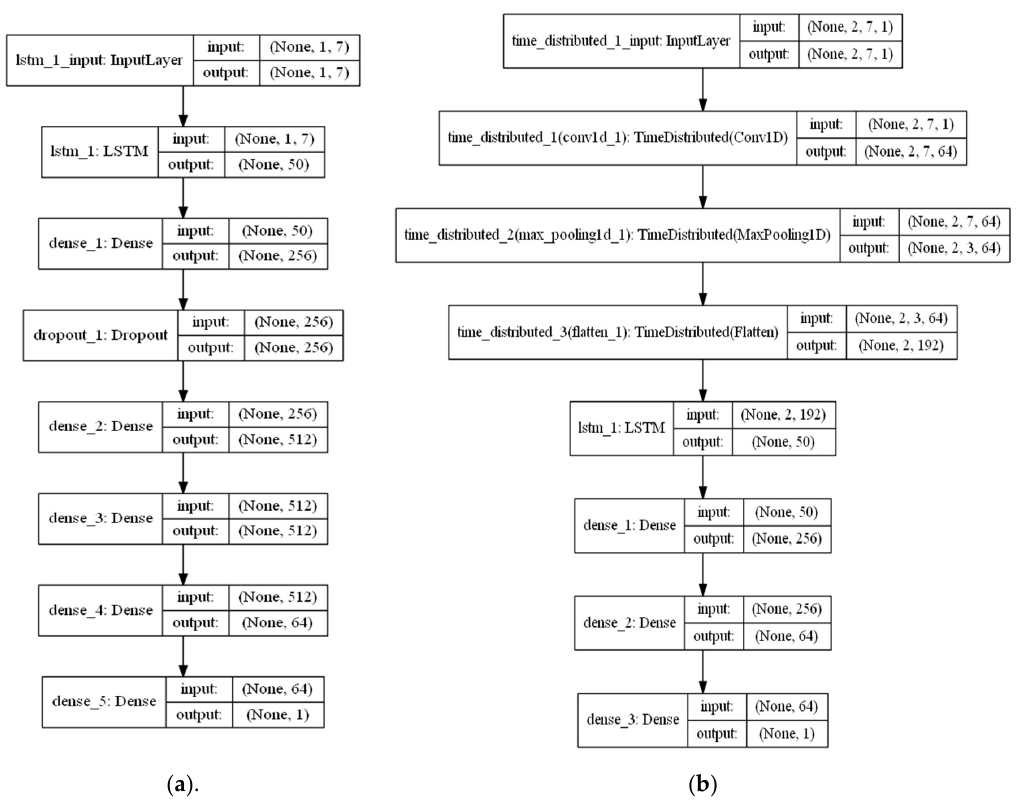
Figure 4. Illustration of the proposed ( a ) recurrent neural network–long short-term memory (RNN–LSTM); and ( b ) convolutional neural network–long short-term memory CNN–LSTM network for dam inflow prediction.